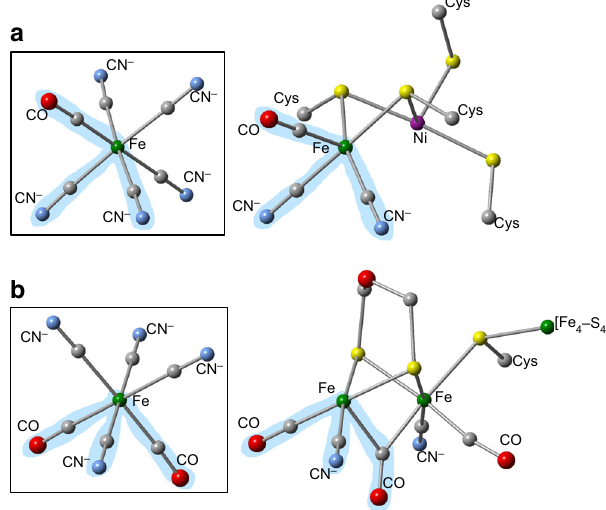
Fig. 3 Meteoritic organometallic compounds compared to active sites. a [Fe II (CN) 5 (CO)] 3 − (boxed) and active-site structure of [NiFe]- hydrogenase from Desulfovibrio gigas (1FRV). b [Fe II (CN) 4 (CO) 2 ] 2 −